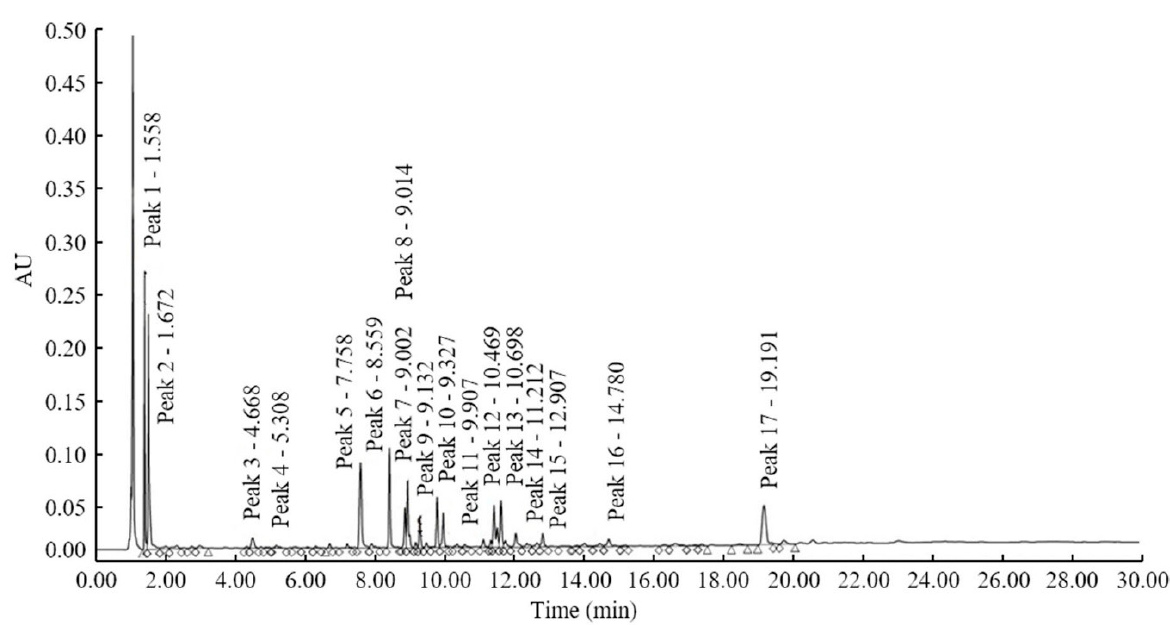
Figure 1. Analysis of the concentrations of resistant metabolites by means of high-performance liquid chromatography analysis after inoculation with Xanthomonas oryzae pv. oryzae (Xoo) in a 120 Cheongcheong/Nagdong double haploid (CNDH) population. A total of 17 metabolites were analyzed, and the concentration of metabolites produced after inoculation of the 120 CNDH population of Xoo varies according to the bacterial leaf blight (BLB)-resistant population and the susceptible population. Peak 1 is 1.558 min, Peak 2 is 1.672 min, Peak 3 is 4.668 min, Peak 4 is 0 min, Peak 5 is 7.758 min, Peak 6 is 8.559 min, Peak 7 was detected at 9.002 min, Peak 8 at 9.014 min, Peak 10 at 9.327 min, Peak 11 at 9.907 min, Peak 12 at 10.469 min, Peak 13 at 10.698 min, Peak 14 at 11.212 min, Peak 15 at 12.907 min, Peak 16 at 14.780 min, and Peak 17 at 19.191 min. Above the peak is the detected peak number and the detected time.